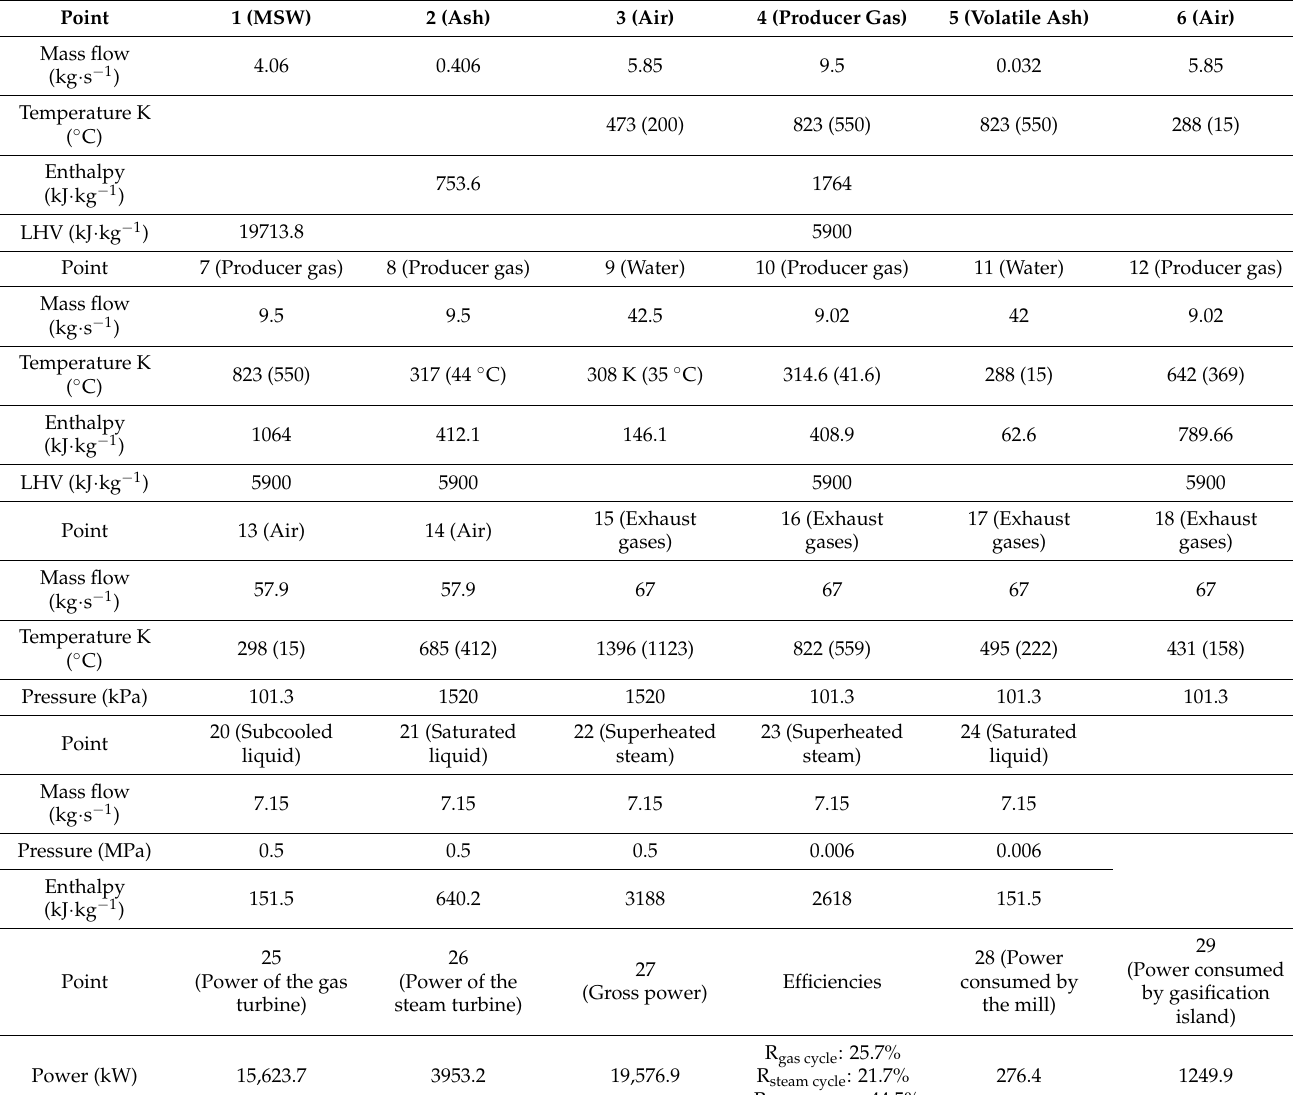
Table 1. Mass and energy